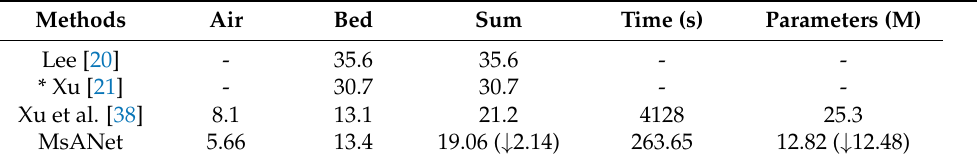
Table 7. Results compared with other methods using 8 segments of data to train and test. The method marked with “*” is the method of Xu et al. [21] which removes the ice mask